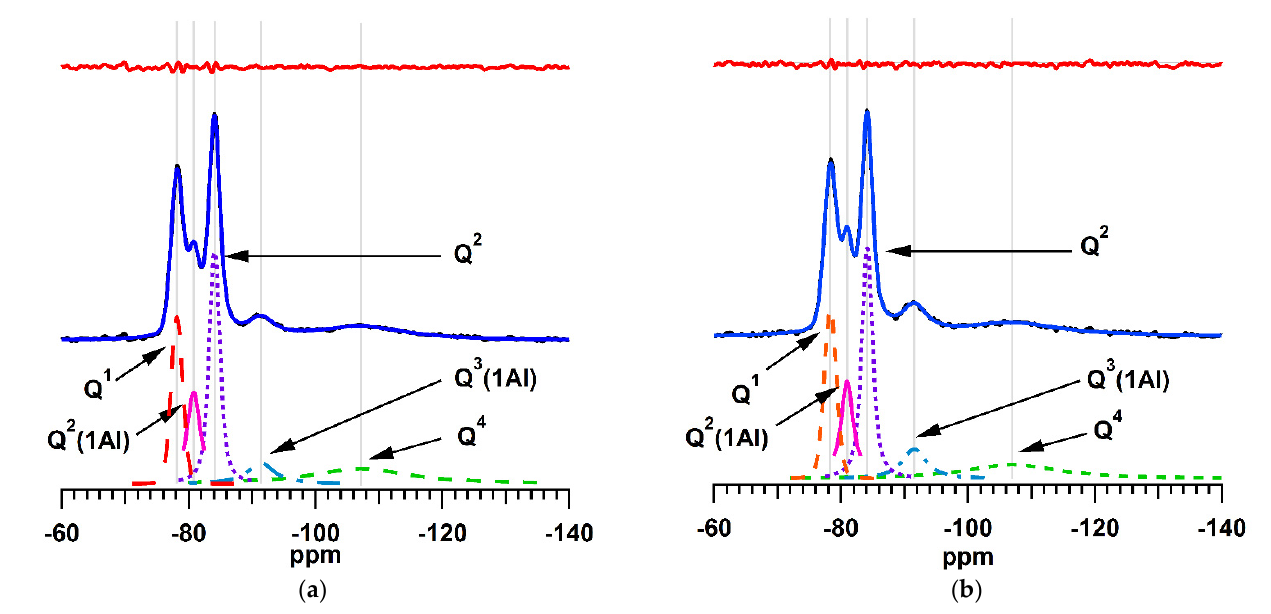
Figure 4. 29 Si MAS NMR spectra of ( a ) tobermorite product TG4 and ( b ) tobermorite product TA4. The calculated spectra are depicted as continuous royal blue lines superimposed over the experimental spectra (shown in black). The individually resolved resonances are presented as dashed lines. The residual between the calculated and experimental spectra is shown in red above the spectra. Table 2. Structural properties of tobermorites derived from green (TG4) and amber (TA4) cullet. Sample